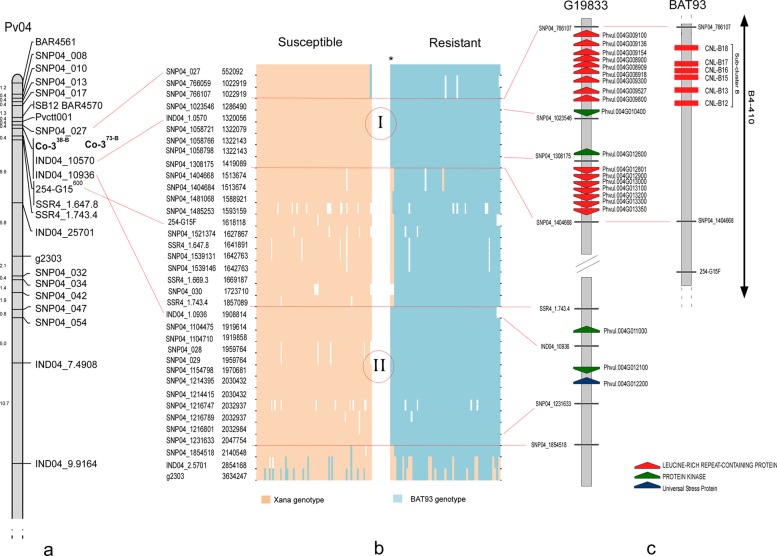
Genetic and physical mapping of the gene conferring resistance to race 38 in the beginning of linkage group Pv04.A) Fine map obtained for the linkage group Pv04 in the region of the cluster Co-3. B) Graphical representation of XB RIL population genotype observed within the region flanked by the markers SNP04_027 and g2303 based on the physical positions of informative (mapped) and redundant SNP markers (non recombination with mapped markers). I and II, regions without recombination in the XB population, all lines showed the same genotype for the loci. White gaps represent missing data. C) Genes related with reaction to biotic stresses annotated in the candidate region for the resistance gene to race 38 (Co-338-B) in the G19833 genome and in the BAC B4-410 [48]. *, lines XB28 and XB212.